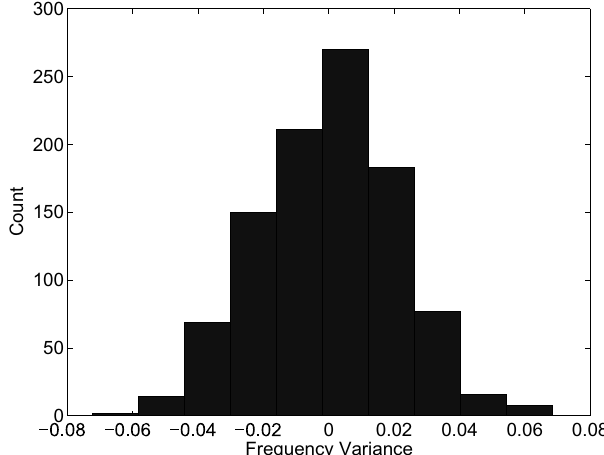
Fig. 5. Histogram of 1000 random blade